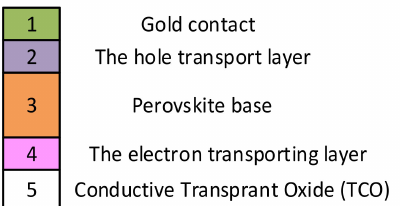
Figure 10. An example of a planar structure of a perovskite-based photovoltaic cell